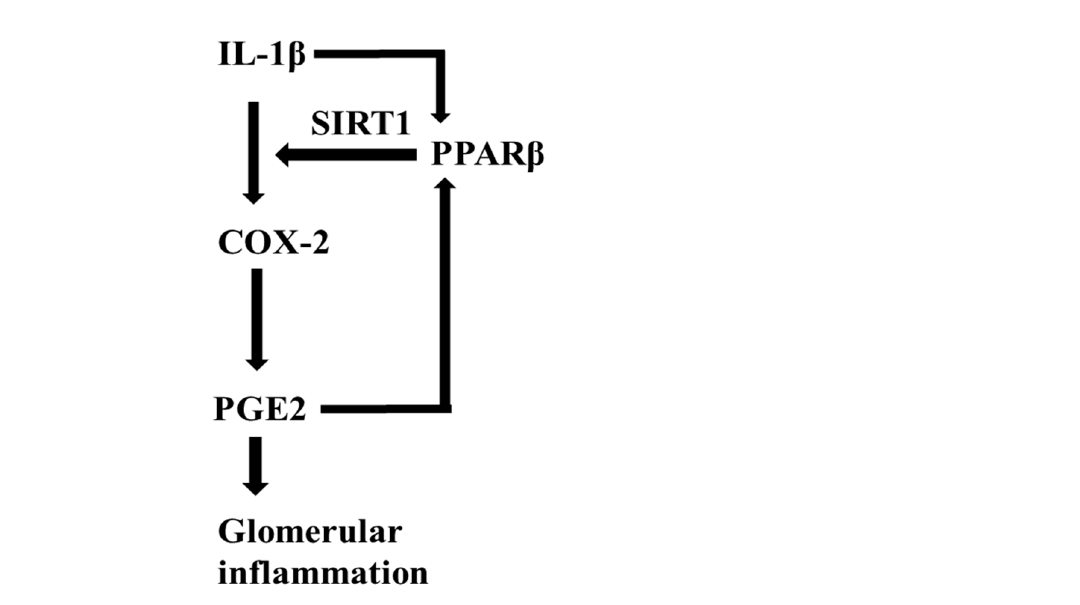
Figure 8. Proposed model of the vicious cycle between PPAR β / δ and COX-2 in IL-1 β -induced PGE2 production in human mesangial cells. IL-1 β could induce PPAR β / δ expression in both dose- and time-dependent manners accompanied by increased COX-2 expression and PGE2 production. The activation of PPAR β / δ exacerbated the IL-1 β -induced COX-2 expression and PGE2 production essentially through inducing SIRT1 expression and activity to promote glomerular inflammation. PPAR β : PPAR β / δ .